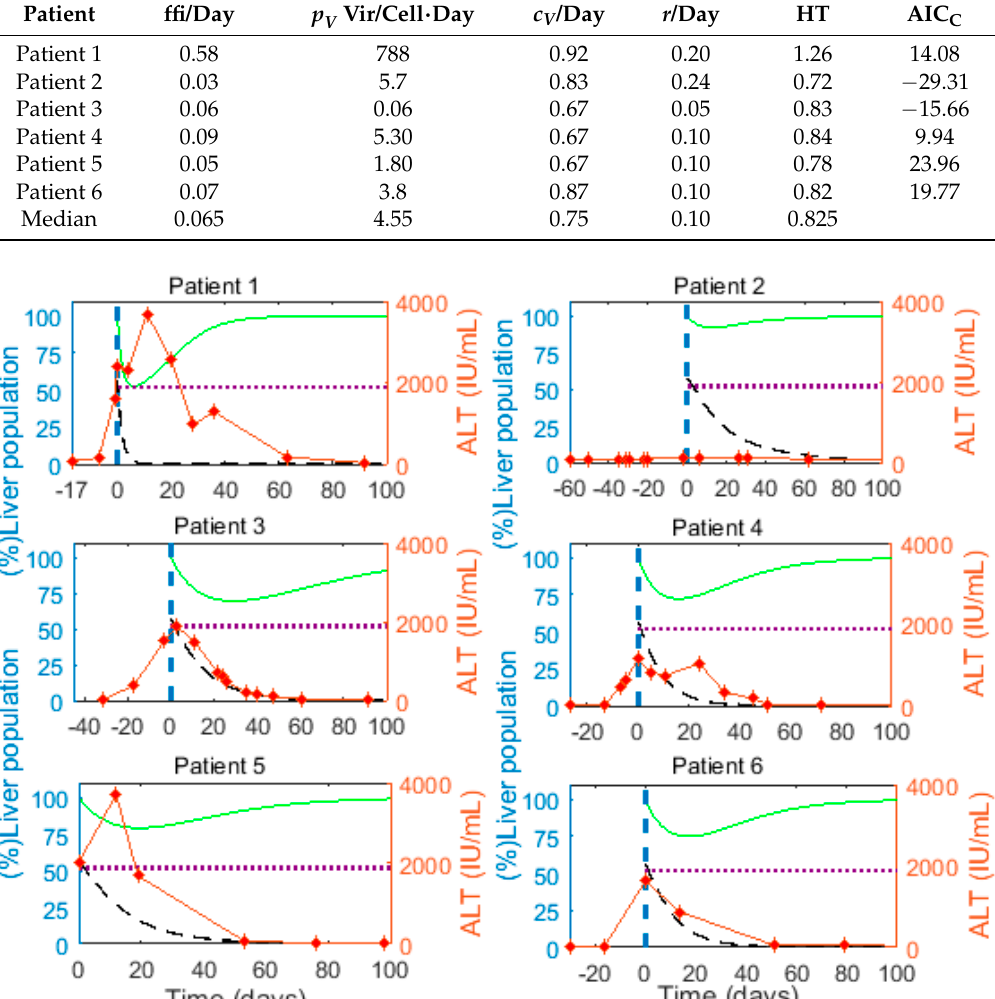
Table 3. Parameters for best fits for six patients using M1 . The parameters δ , p V , c V , r , HT and AIC C represent the infected cell loss rate, the per infected cell production rate of HBV, the clearance rate of HBV, the proliferation rate, hepatocyte turnover and corrected Akaike information criterion, respectively.